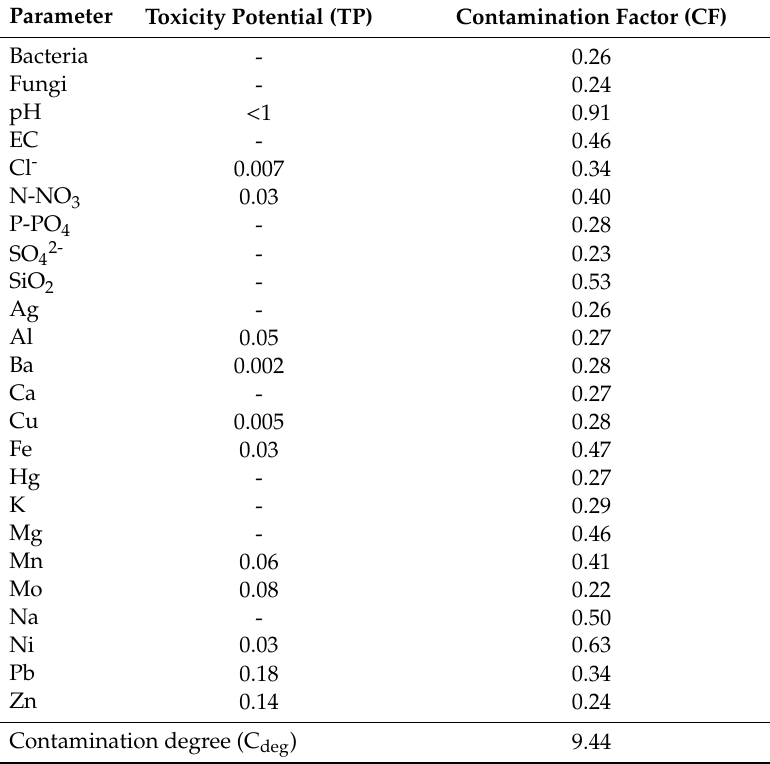
Table 4. Ecological risk values of roof runo ff in Krak ó